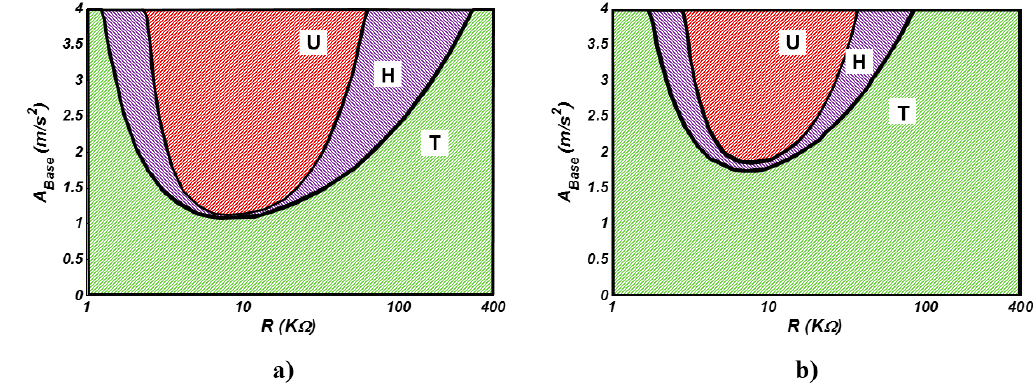
Figure 13. Definition of three regions with different system responses including “T”: traditional bended curve, “H”: Hopf bifurcation occurrence and “U”: unstable region appearance, for ( a ) Q = 300 and ( b ) Q = 200.